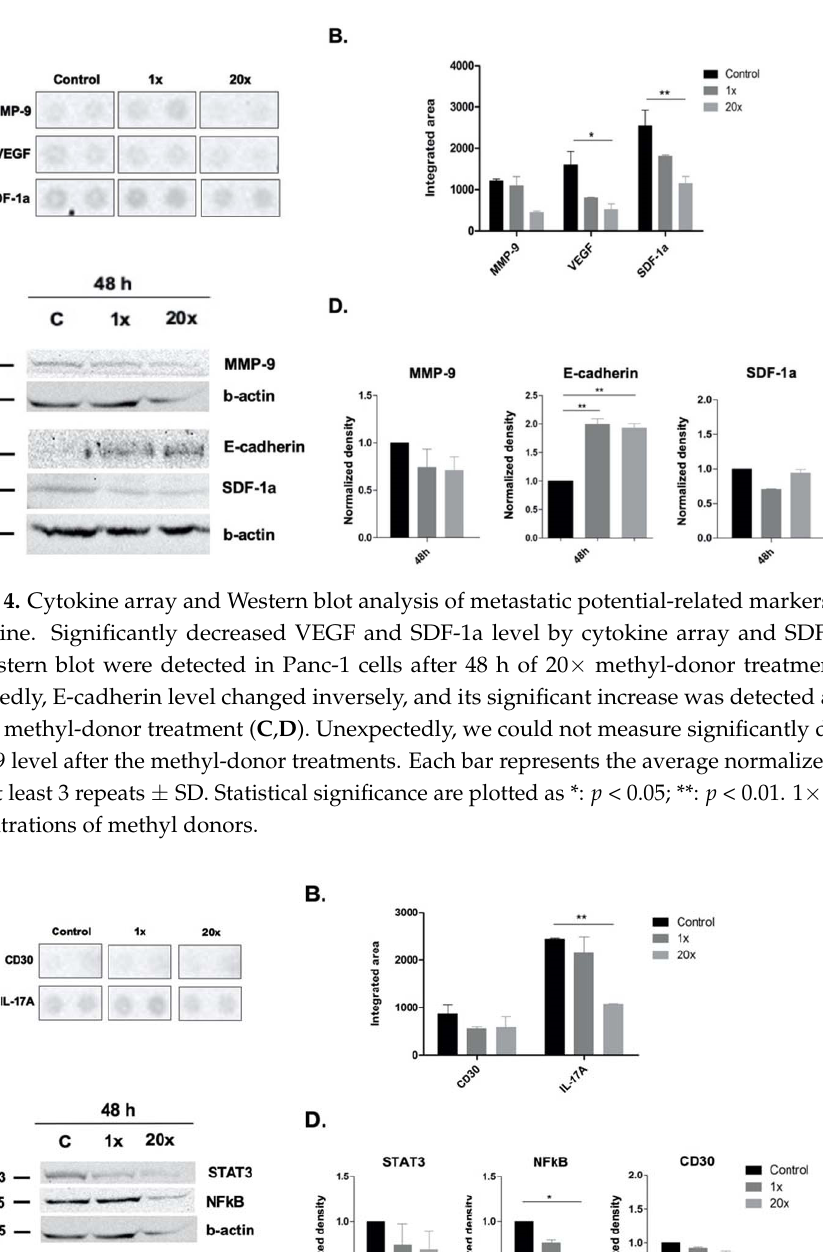
Figure 5. Cytokine array and Western blot analysis of inflammation-related markers in Panc-1 cell line. Significantly decreased level of IL-17a measured by cytokine array and NFkB by Western blot